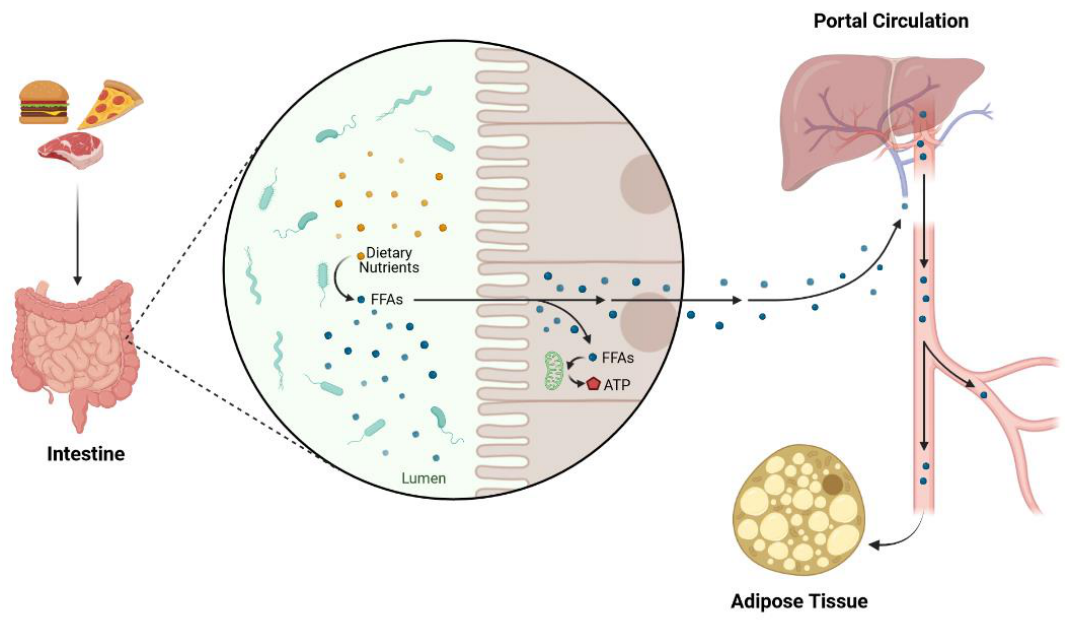
Figure 2. Summary of the nutrients’ absorption, lipid synthesis, and storage in adipose tissue.